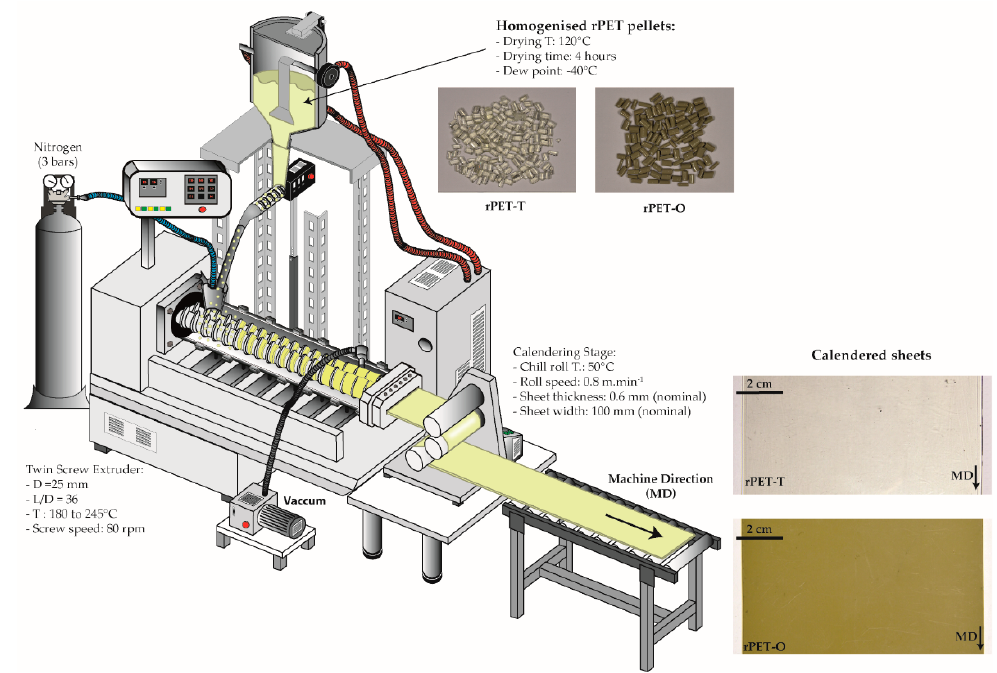
Figure 2. Schematic representation of the extrusion-calendering process of rPET sheets.